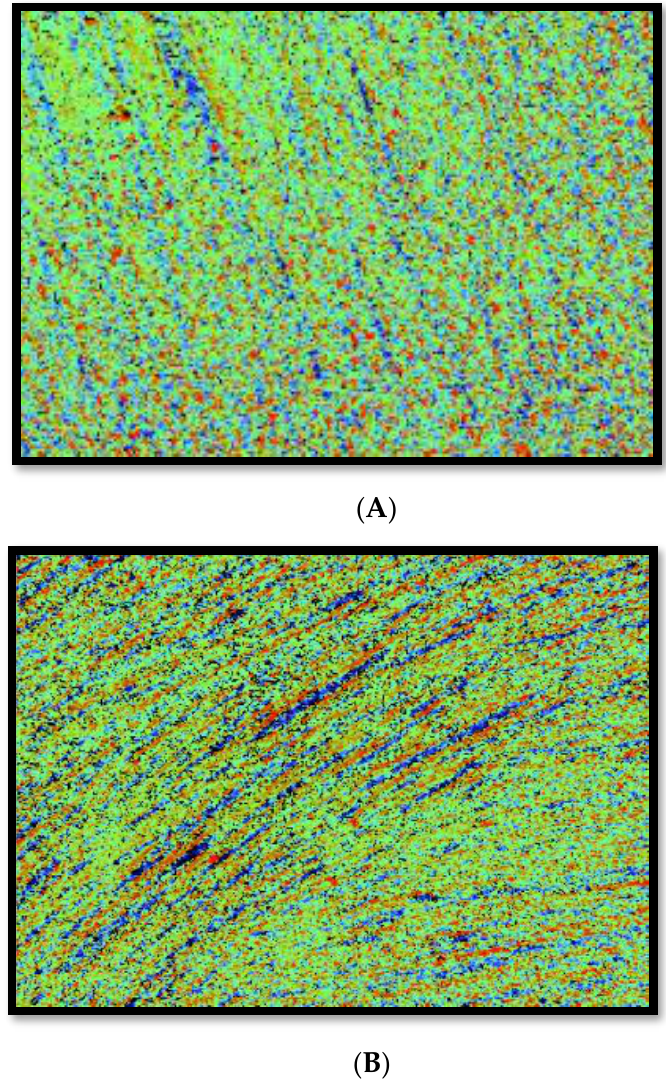
Figure 5. Surface roughness micro-graphs for the first ( A ), and third ( B ) firing samples.